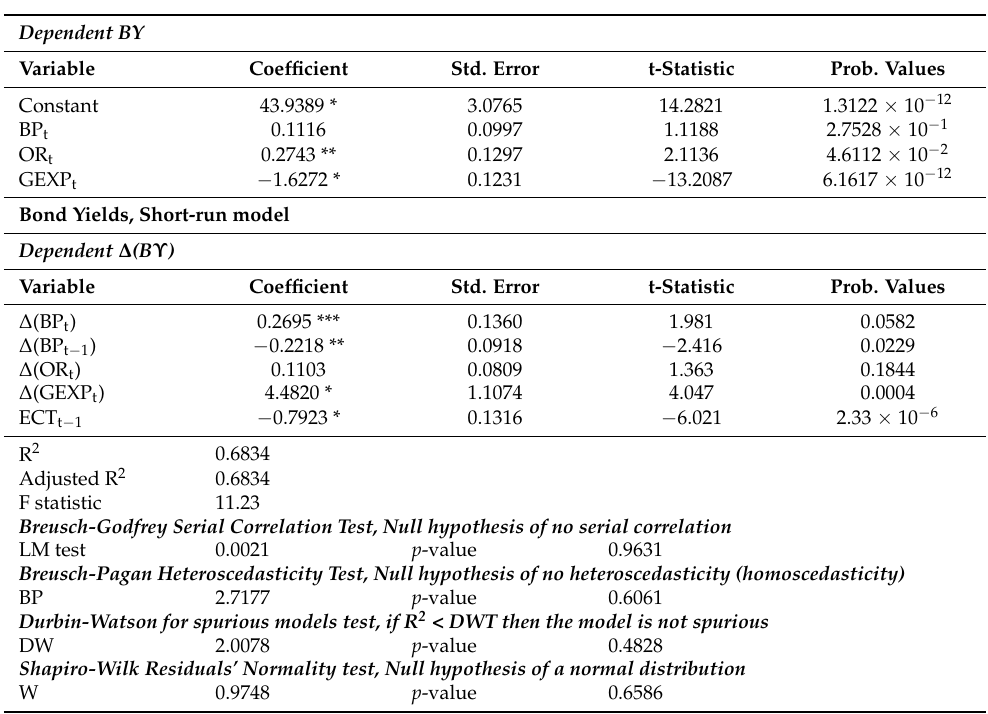
Table 6. Bond yields, long-run model.